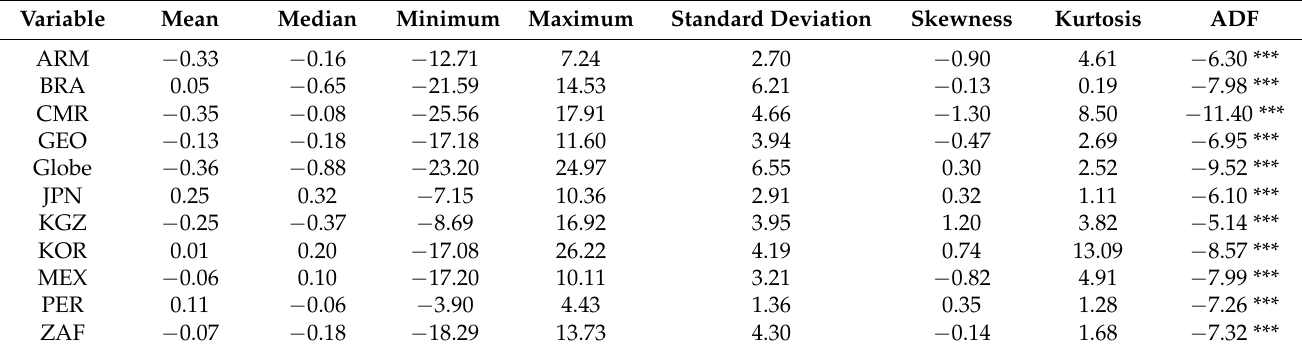
Table 3. Descriptive statistics and augmented Dickey–Fuller test statistics of wheat price returns.